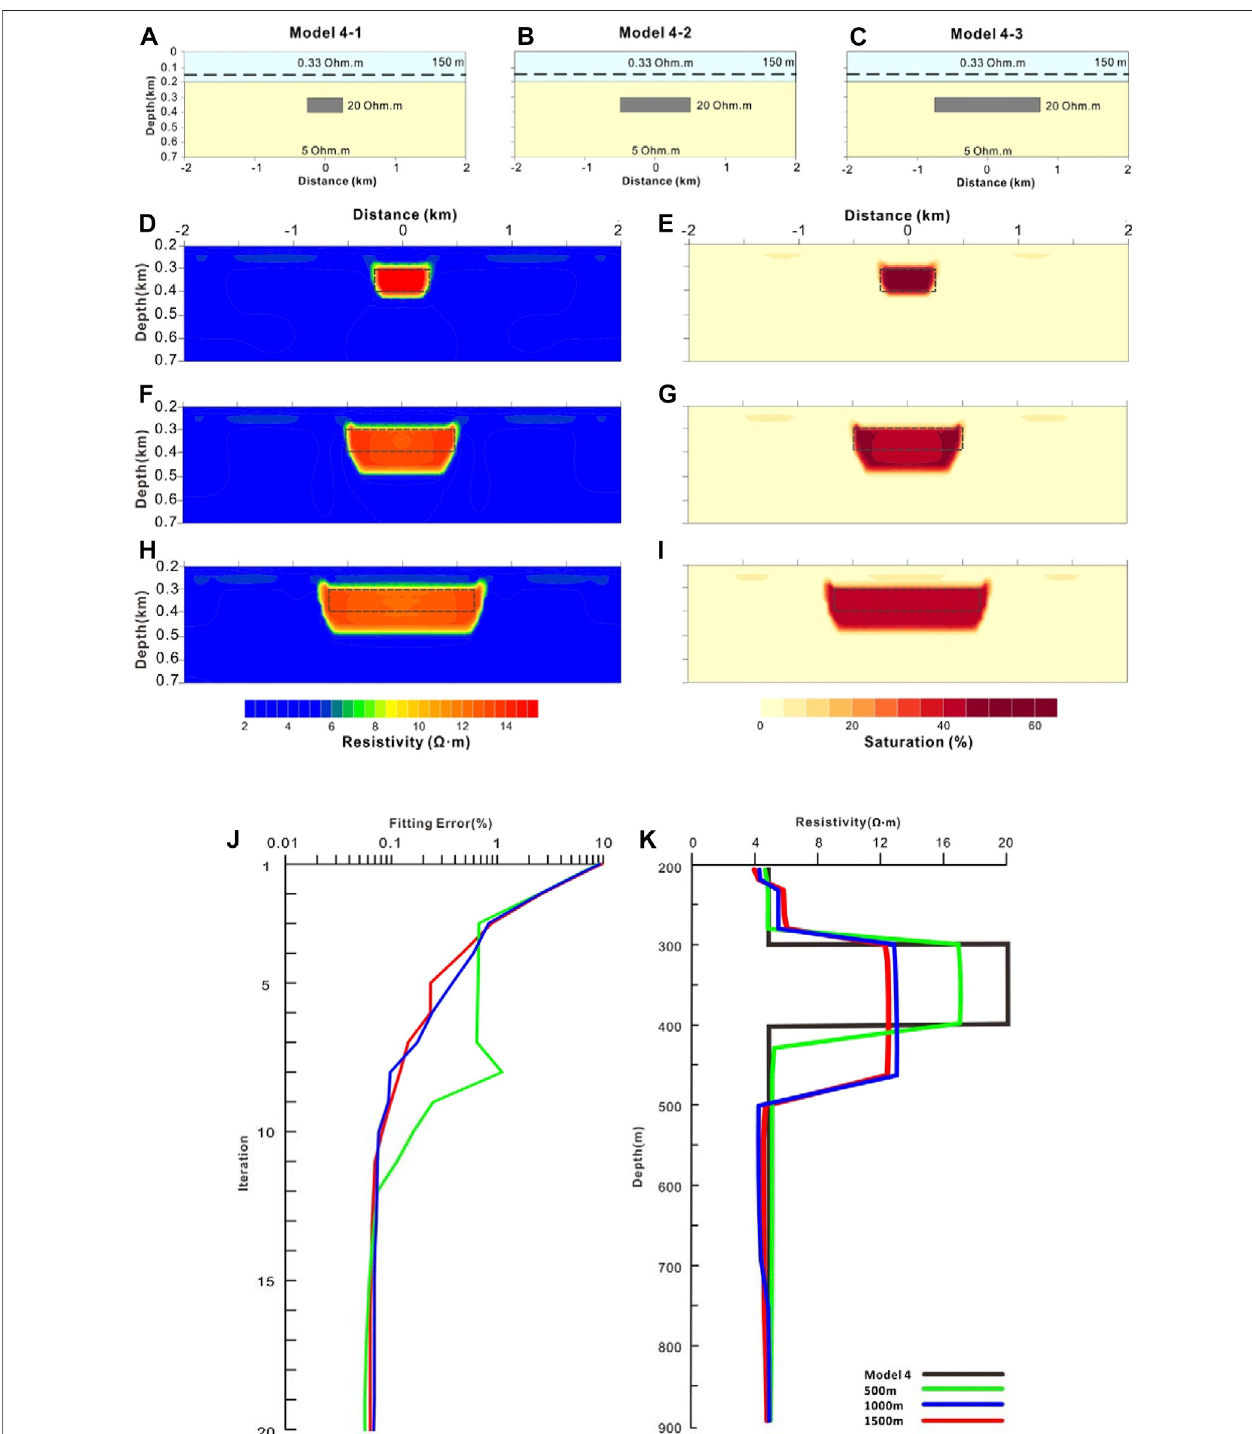
FIGURE7| Resistivityinversionandhydratesaturationestimationofthevariouslengthmodelofhydratereservoir. (A) – (C) :theschematicdiagramofModel4 – 1,4- 2,and4-3respectively,lightblueindicatesseawater,lightyellowindicatesmarinesediments,grayblockindicateshydratereservoirs,dottedlineindicatesthetrackofthe towed DCR array arrangement; (D) , (F) and (H) : the inversion resistivity of Model 4 – 1, 3 – 2, and 4-3 respectively; (E) , (G) and (I) : the hydrate saturation estimation of Model4 – 1,4 – 2,and4-3respectively (J) :theinversioniterationconvergenceofModel4 – 1(green),4 – 2(line)and4 – 3(red),respectively (K) :theresistivitypro fi lewith depth at the center x position of hydrate reservoir of Model 4 – 1(green), 4 – 2(blue) and 4 – 3 (red), respectively.